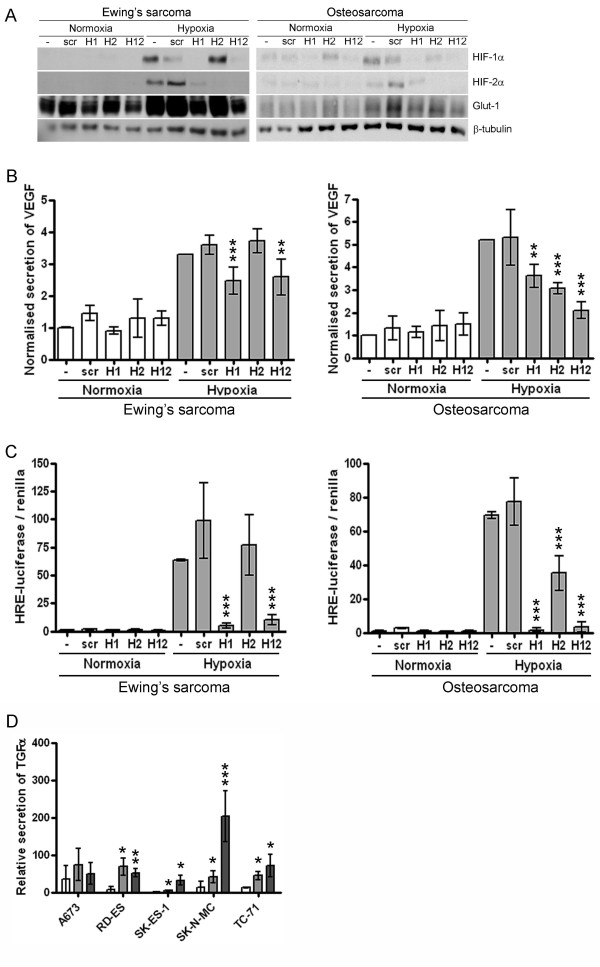
HIF siRNA in ES and OS cell lines. (a) Western blots showing expression of HIF-1α (120 kDa), HIF-2α (120 kDa) and Glut-1 (50 kDa) in response to siRNA targeting HIF-1α (H1), HIF-2α (H2), HIF-1α and HIF-2α (H12) or control siRNA (scr) in ES (SK-N-MC) and OS (143B) cells. Effects of HIF siRNA on (b) secretion of VEGF and (c) activation of the HRE-luciferase reporter construct and in response to hypoxia or low glucose in ES and OS cell lines. Bar graph data is normalised to the siRNA mock control (-) for each condition and represents pooled data from the entire panel of ES or OS cell lines. *, p < 0.05; **, p < 0.01; ***, p < 0.001 versus scr siRNA control. (d) Secretion of TGFα from ES cell lines in response to hypoxia (light grey bars) or low glucose (dark grey bars). *, p < 0.05; **, p < 0.01; ***, p < 0.001.